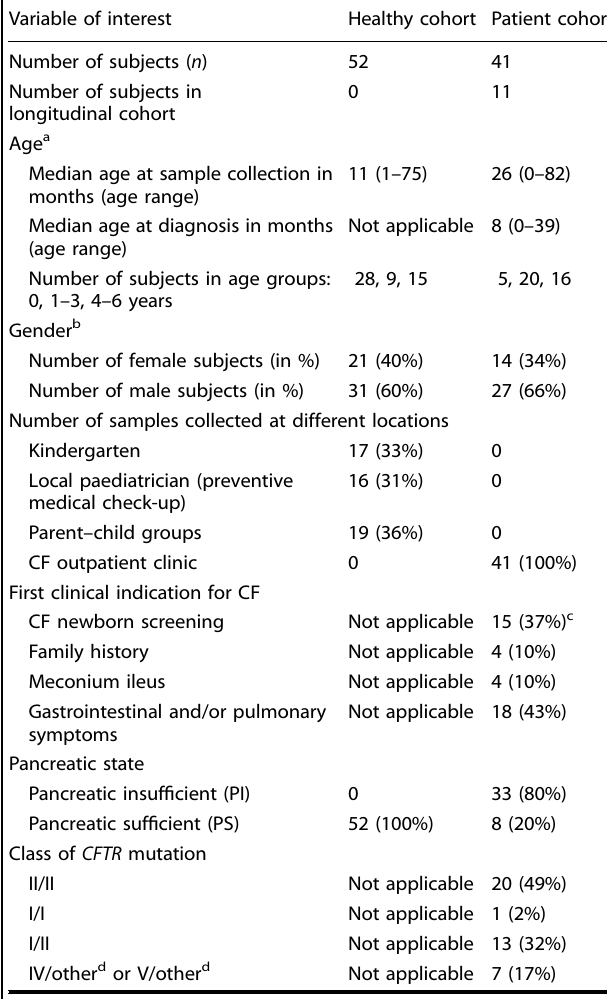
Table 1. Metadata of healthy and CF-diagnosed participants.